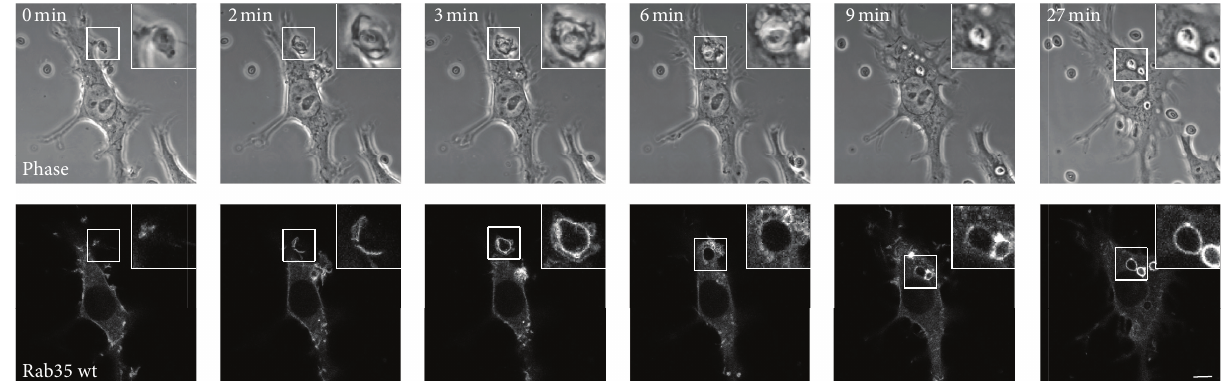
Figure 1: Rab35 is recruited to the phagocytic cups. Live RAW264 macrophages expressing GFP-Rab35 were incubated with zymosan and were observed by confocal laser microscopy. Phase-contrast images are shown (upper panels). The elapsed time is indicated at the top. The binding of zymosan to the cell surface was set as time 0. The insets show higher-magnification images of the indicated regions of the cells. Scale bar: 5 𝜇